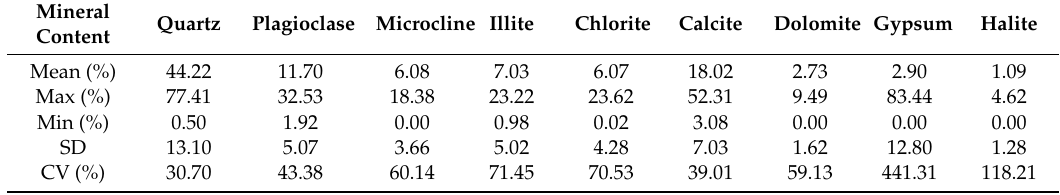
Table 5. Mineral content percentage in the study area [21,22]. (SD: Standard Deviation, CV: Coe ffi cient of